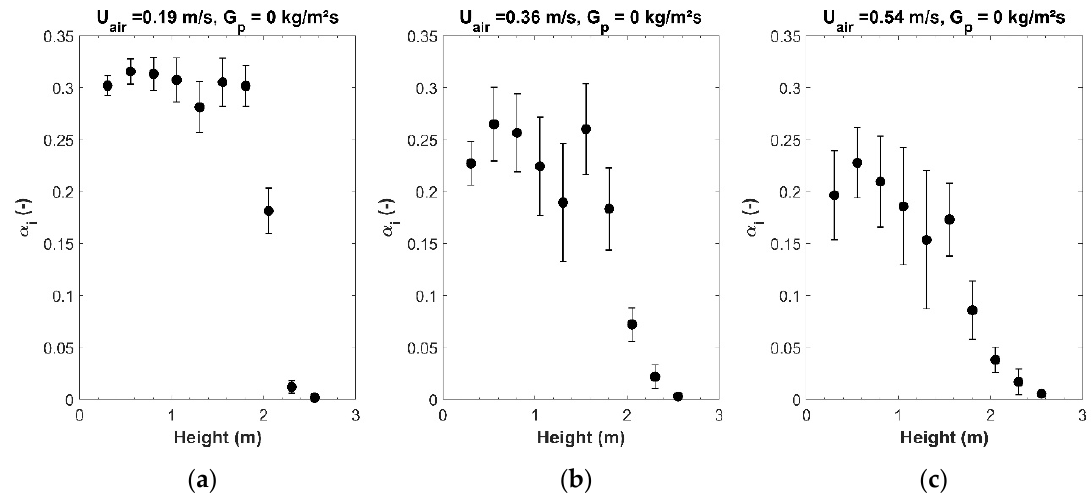
Figure 6. Evolution of the local solid volume fraction with the height in the tube, for three aeration flow rates: ( a ) 0.8 sm 3 /h, ( b ) 1.7 sm 3 /h, and ( c ) 2.5 sm 3 /h, without particle circulation.